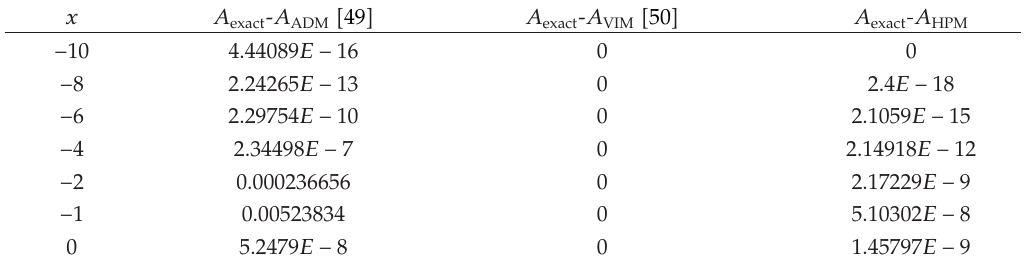
Table 1: Comparison between absolute errors of ADM, VIM, and HPM for t (cid:9) 0 . 001, c (cid:9) 3. x A A (cid:6) 49 (cid:7) exact - ADM